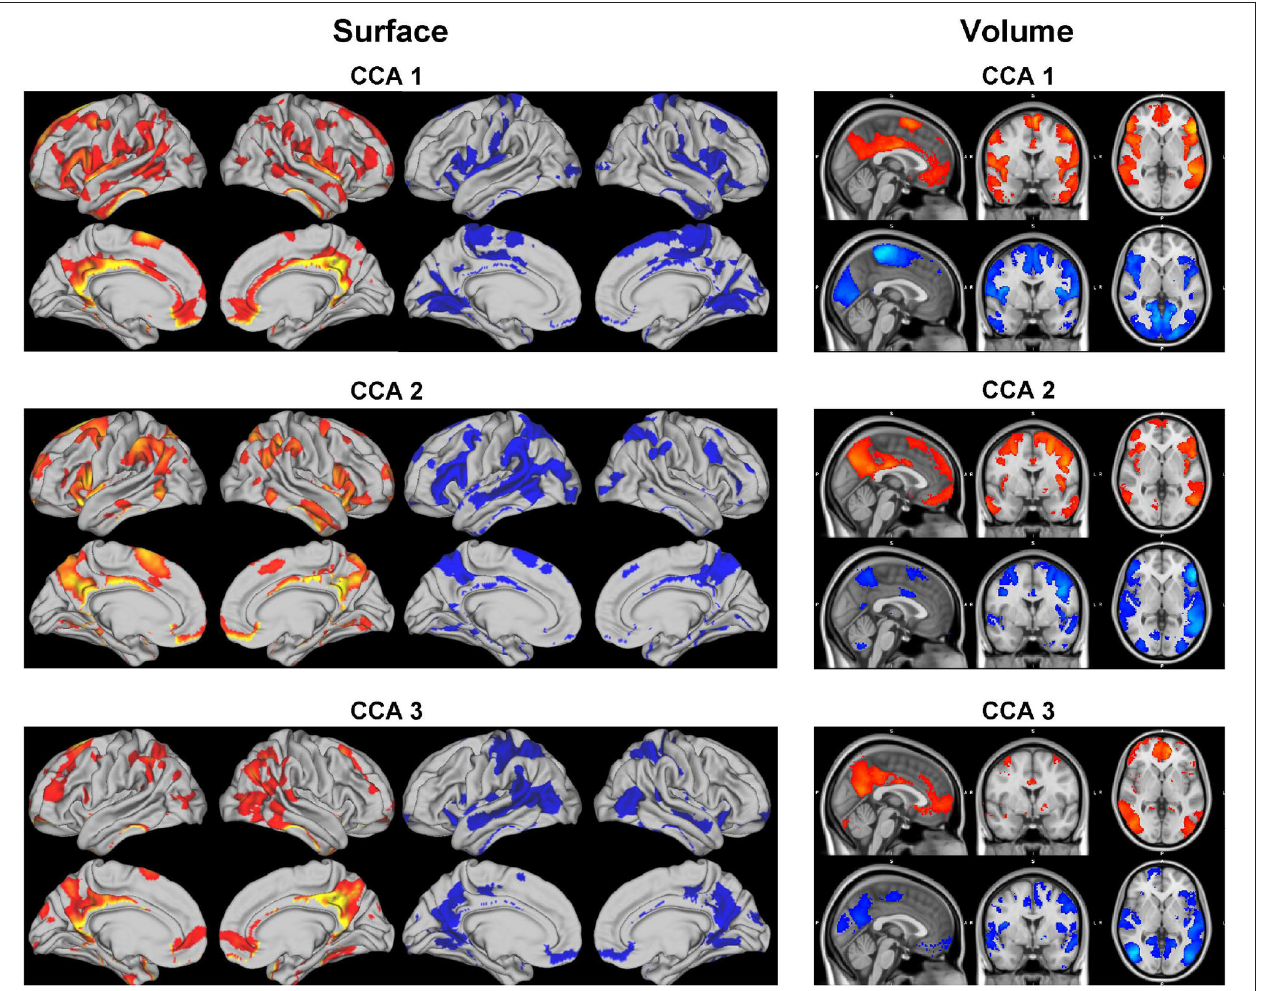
FIGURE 7 | Positive and negative CCA strengths on the brain surface (left) and volume (right) for the 3 significant canonical variables. The visualization is cut by 80%. Positive (red maps) and negative (blue maps) CCA strengths are generated by mapping the canonical loading with the sign of population mean correlation between each pair of ICA regions, then averaging the top 20 positive and negative modulated loadings, respectively.